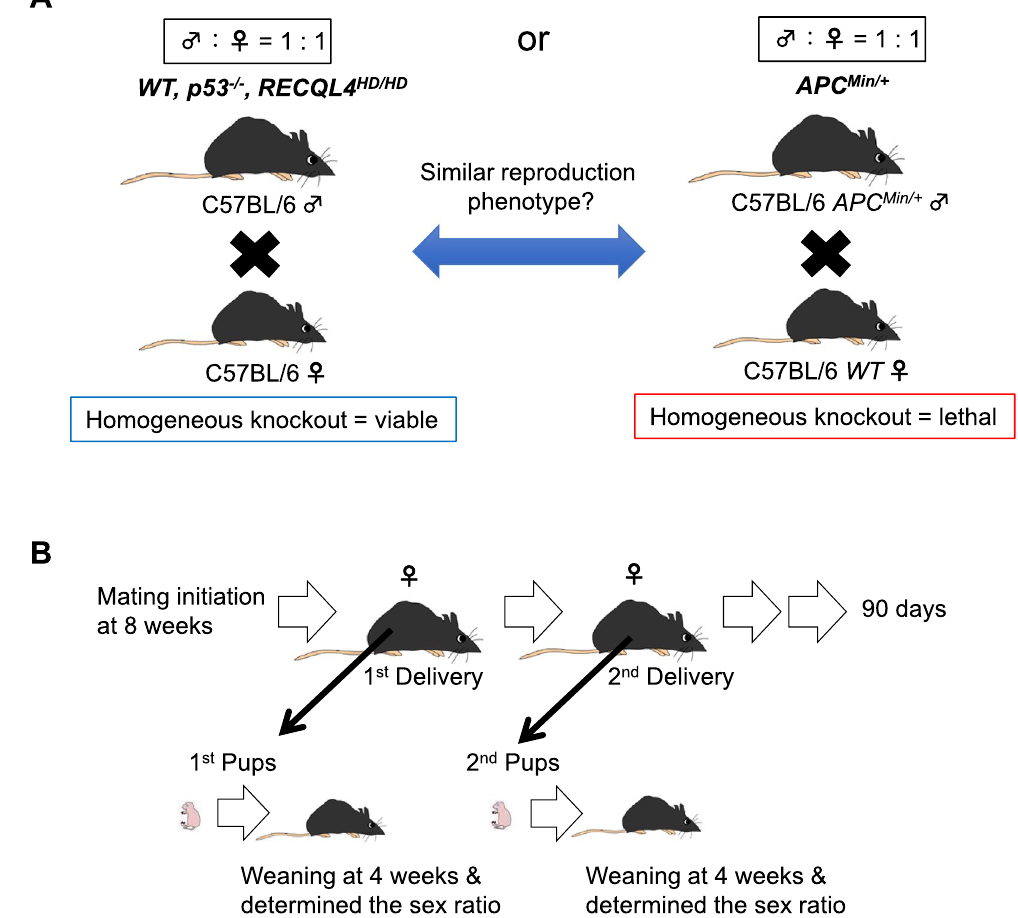
Figure 2. Overview of the experimental process for determining the reproductive ability of transgenic mice. Experimental procedure used for the examination of reproductive ability. ( A ) One-by-one pair mating experiment for understanding reproductive ability. APC Min/Min mice exhibit embryonic lethality, and female APC Min/+ mice have a high likelihood of death within several months. Hence, male APC Min/+ mice and female wild-type mice were used for mating. ( B ) Timing of mating and weaning timing for examining reproductive ability over a definite period (90 days). See the details in the